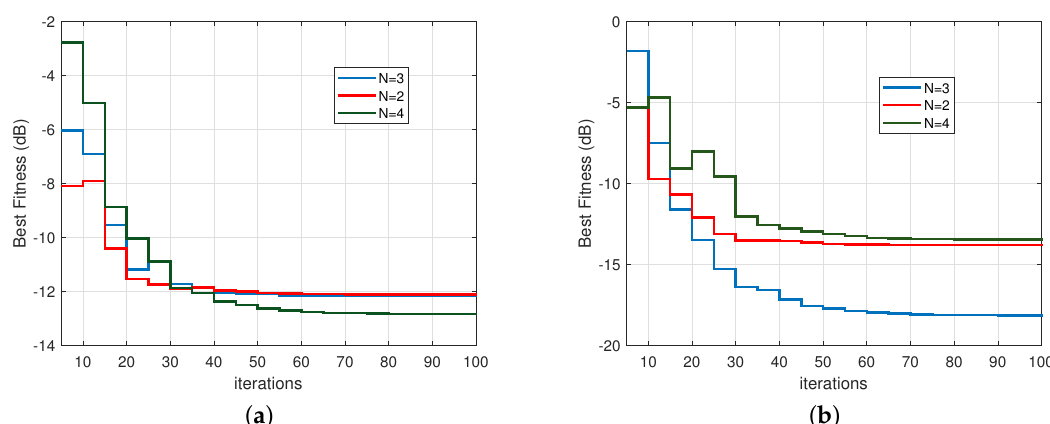
Figure 9. Best fitness function’s values versus the CAPSO algorithm’s iterations for the problems considered in ( a ) Figure 7 and ( b ) Figure 8, presented in stairstep graphs with a 5-iteration step.